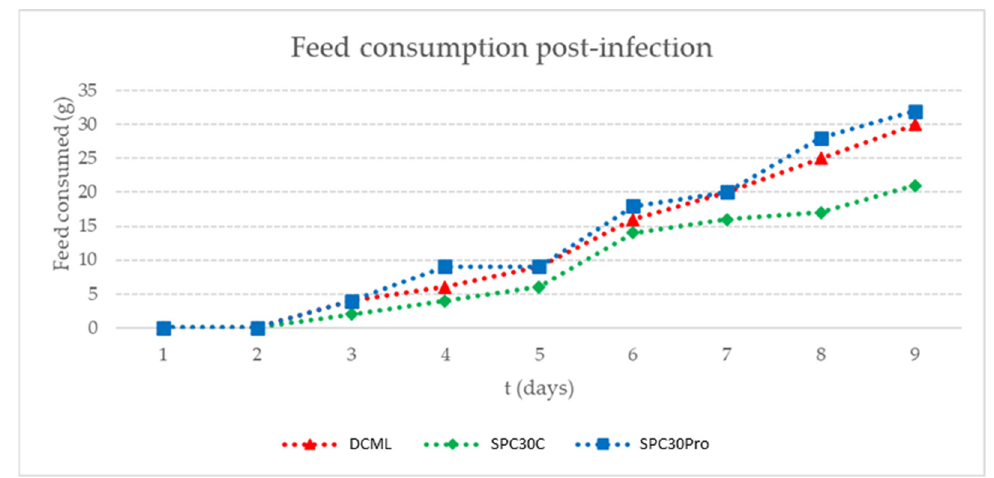
Figure 4. Totoaba macdonaldi feed intake behavior after Vibrio harveyi